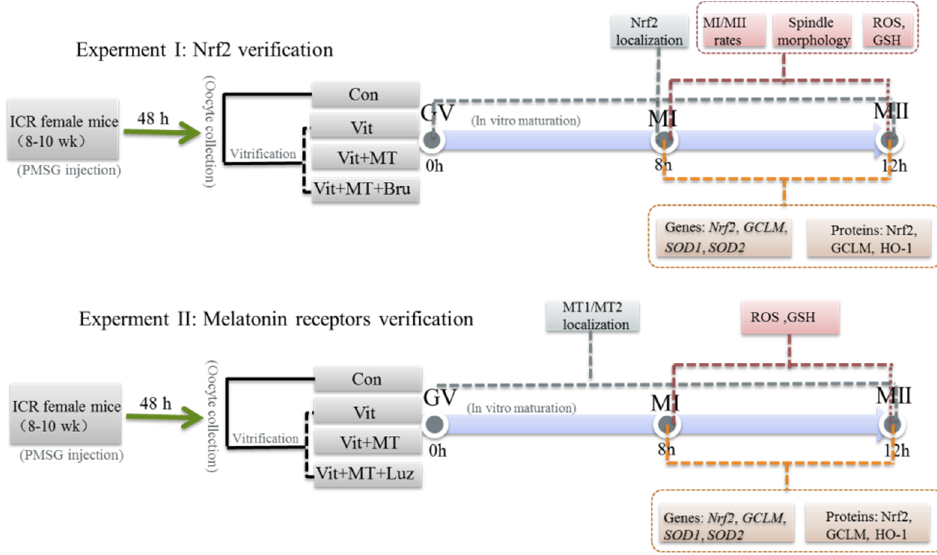
Figure 1. A flowchart of the experimental design. Notes: Brusatol, Nrf2 protein inhibitor; luzindole, Melatonin receptors inhibitor.